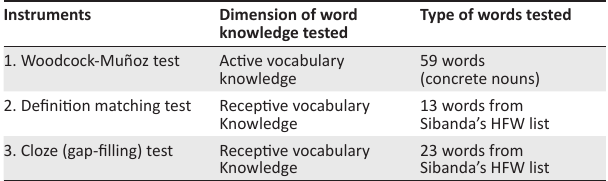
TABLE 2: Vocabulary tests